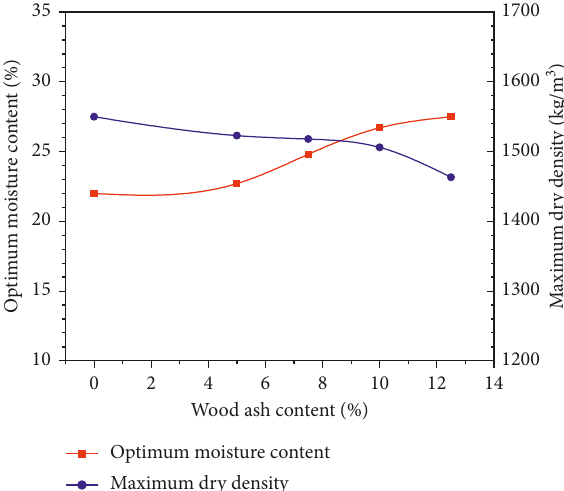
Figure 3: Variation of maximum dry density and optimum moisture content with ash content.